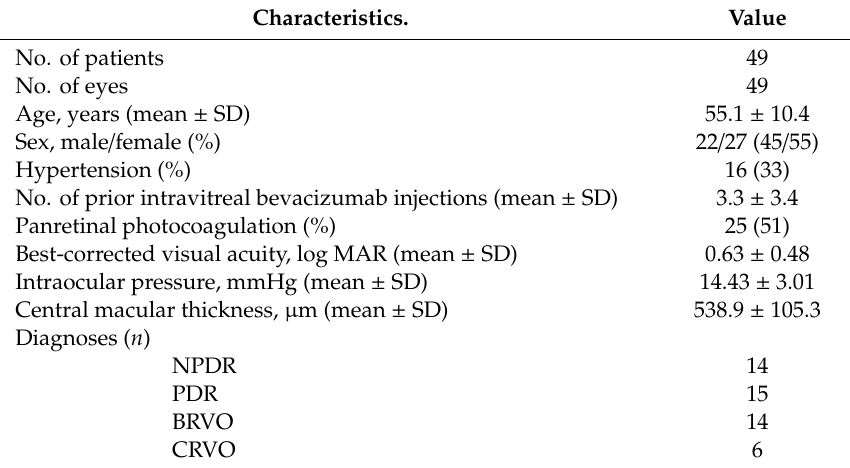
Table 1. Patient demographics and baseline ocular